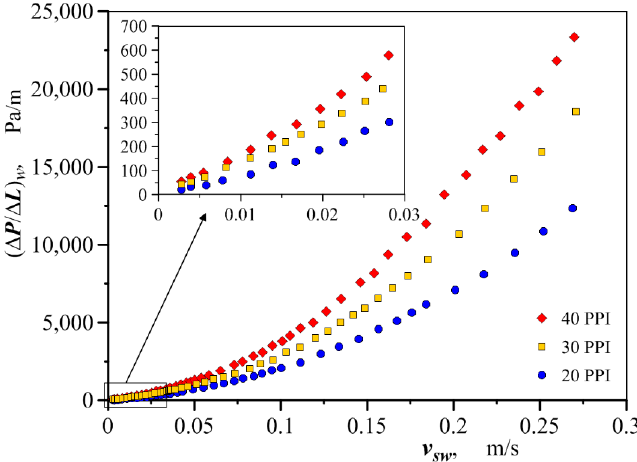
Figure 3. Change in measured pressure drop for air through metal foams as a function of air velocity.